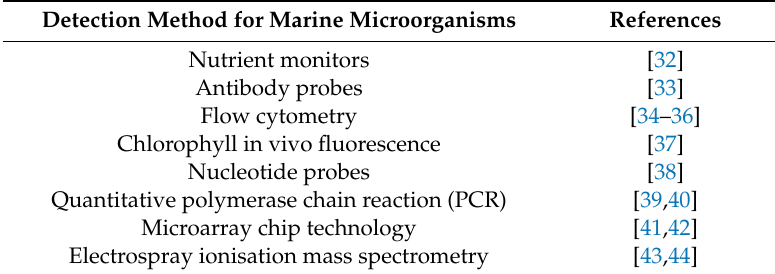
Table 5. In-situ sensors to detect microorganisms in biological